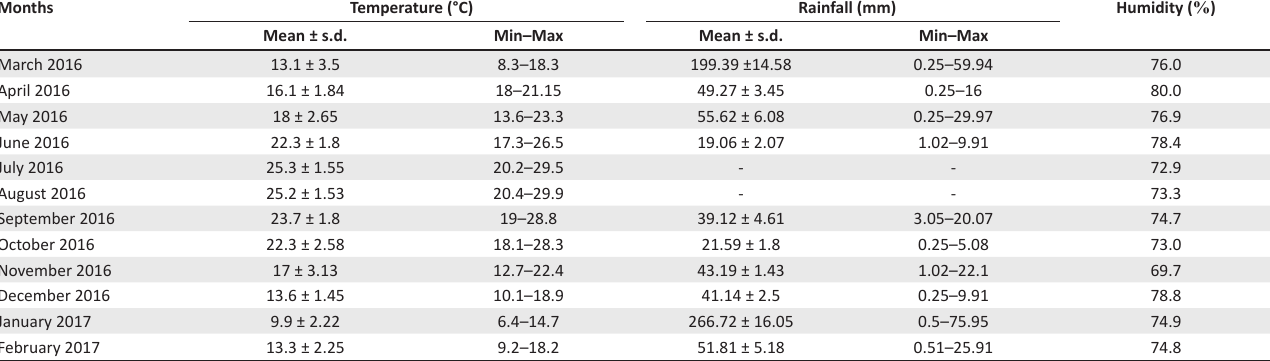
FIGURE 1: Map of the study area, Bejaia (Northern Algeria, latitude 36°43’N and longitude 5°04’E). TABLE 1: Mean ± standard deviation, minimum and maximum value of temperature, rainfall and humidity per month in the Bejaia area, Algeria (2016–2017). Months